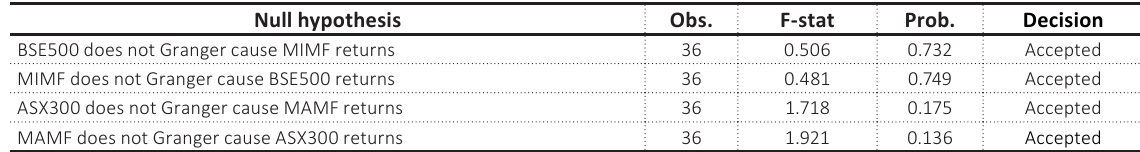
Table 12. Granger causality